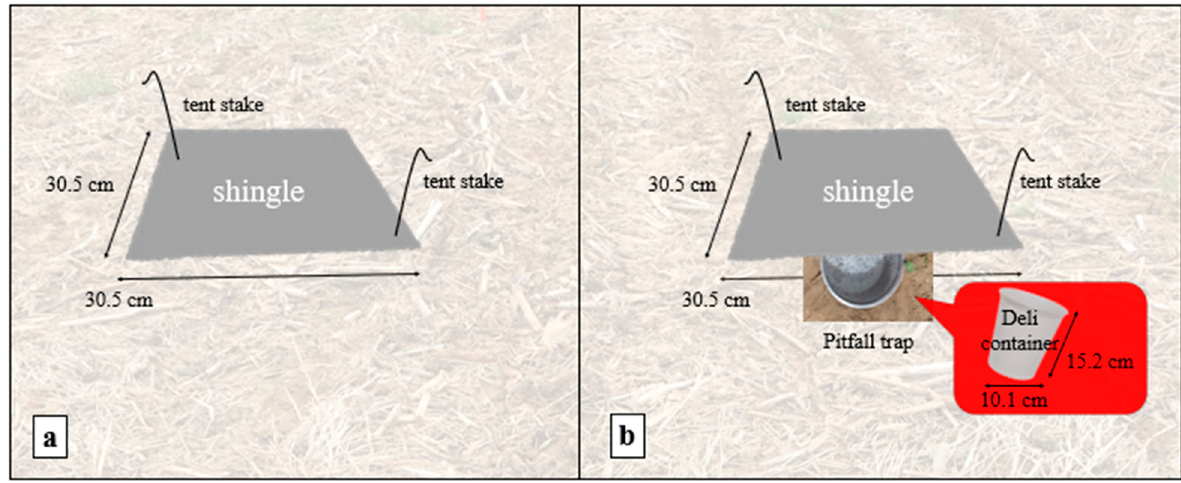
Figure 1. ( a ) Traditional shingle trap and ( b ) modified trap with the shingle placed over a pitfall trap.